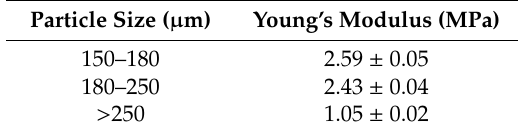
Table 4. Young´s modulus of the composites in function of the magnetic particle size. Table 4. Young’s modulus of the composites in function of the magnetic particle size.